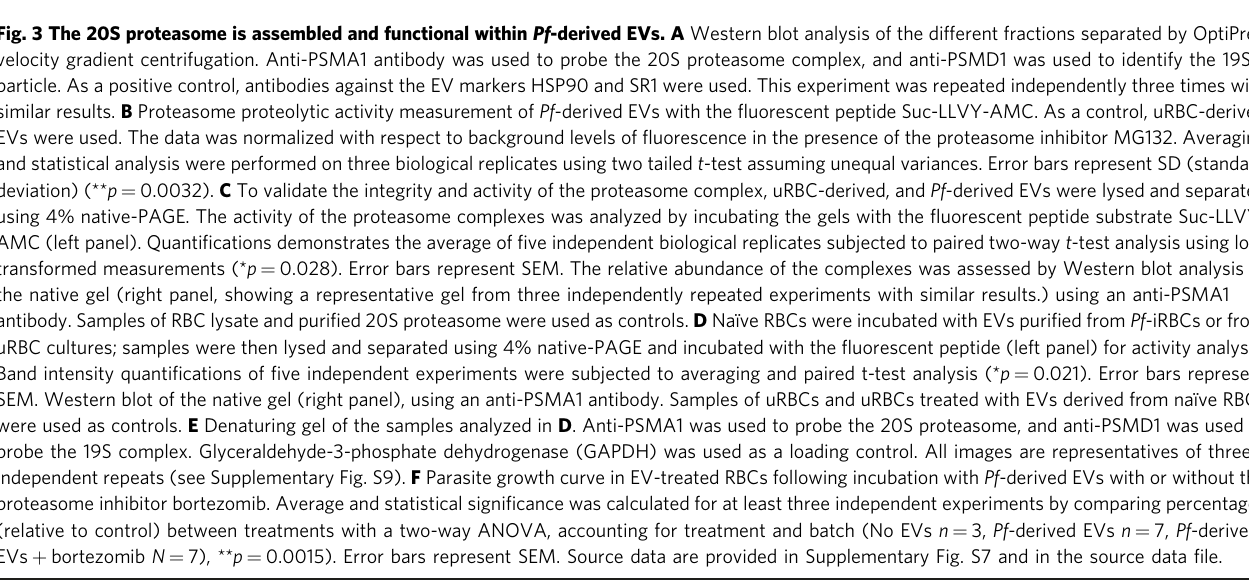
Fig. S7A and S8). All three types of proteasome enzymatic activities were detected in the Pf -derived EVs, namely, caspase- like, chymotrypsin-like and trypsin-like. Using this assay, we found that the proteasome complex is highly active in Pf -derived EVs as opposed to control EVs (Fig.